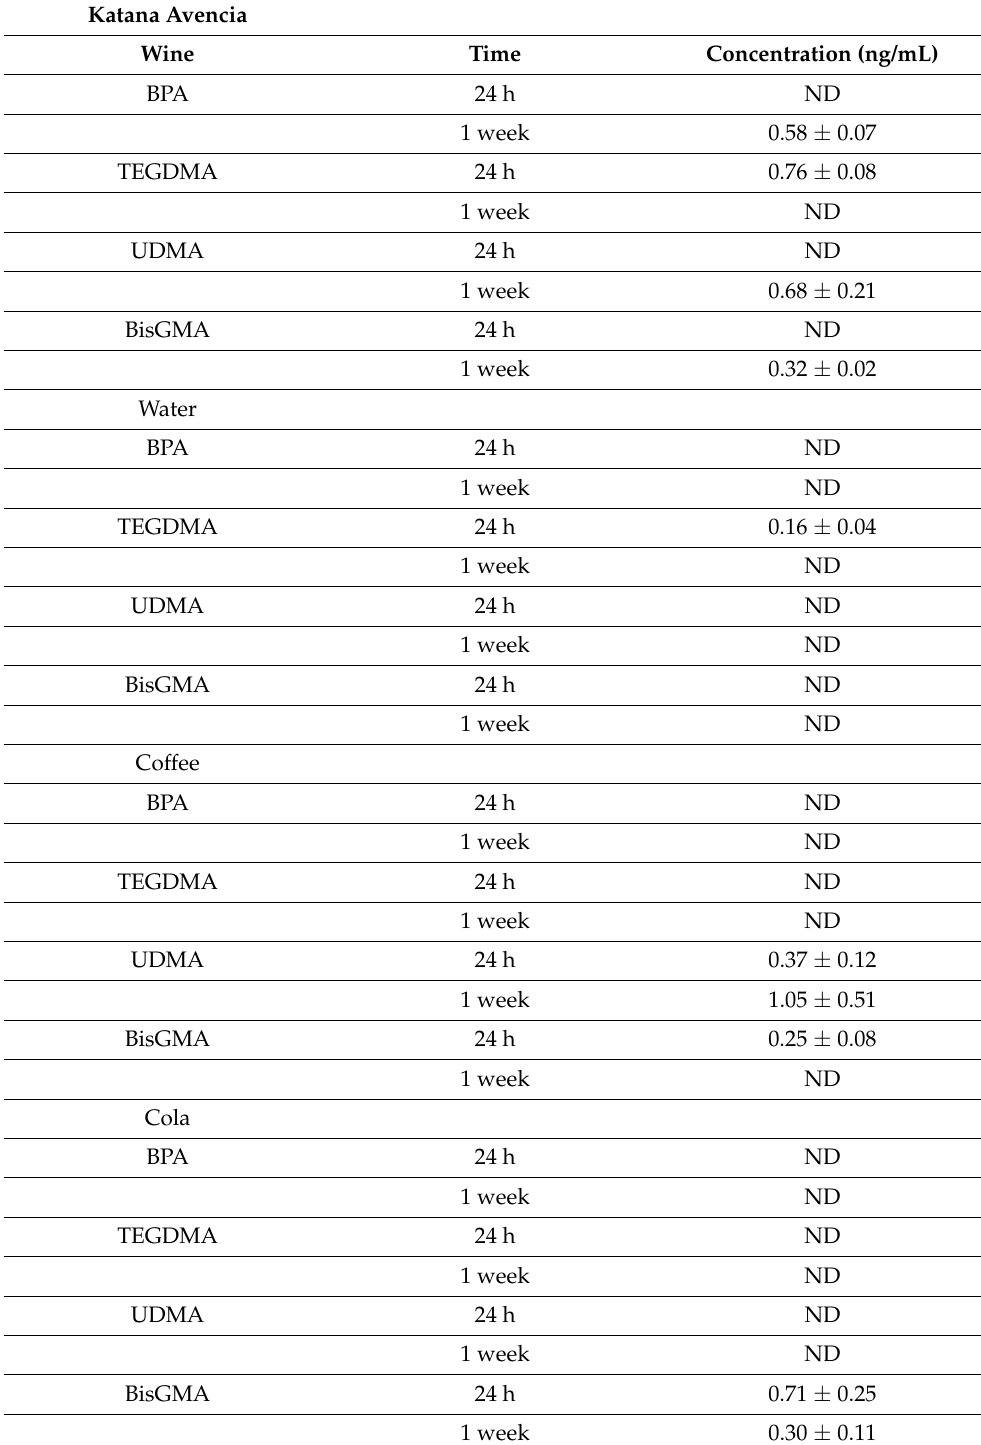
Table 4. Eluted impurities (Mean ± standard deviation, ng/mL) for Katana Avencia after incubation in all beverage solutions and each time